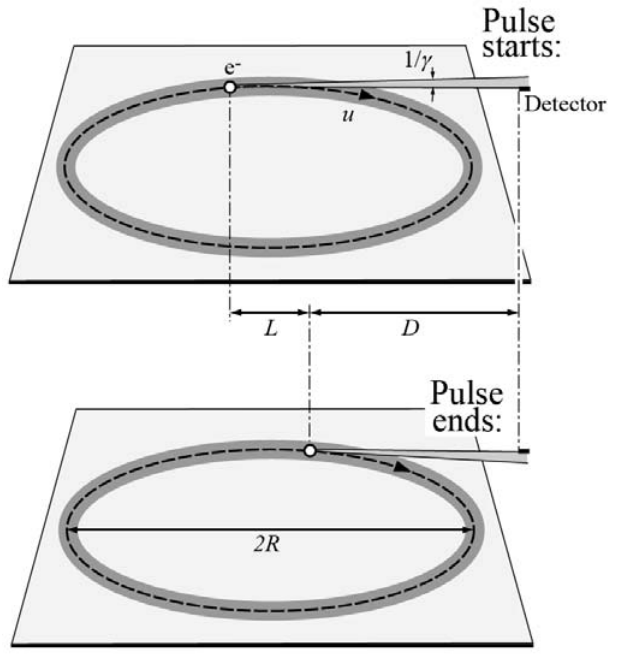
Figure 4. Schematic illustration of how the “torchlight” effect and relativity explain the fact that synchrotron light is spectrally centered in the x-ray